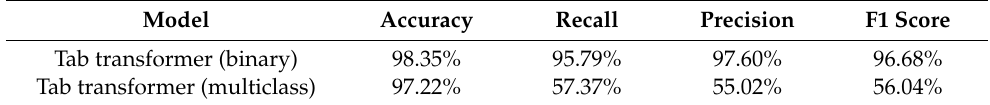
Table 5. Performance evaluation of the tab transformer.